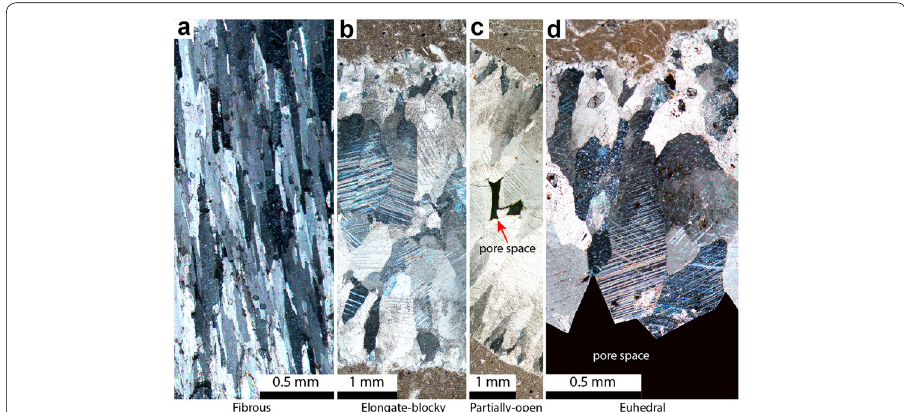
Fig. 1 Natural samples of calcite veins in Jurassic limestones from southern England exhibiting a fibrous, b elongate-blocky, c partially open, and d euhedral morphologies. The wall rock in fibrous veins is not contained in the sample, but is located towards the base of the image in a . Different interference colors of vein crystals depict different crystallographic orientations. All images are obtained from transmitted microscopy and crossed